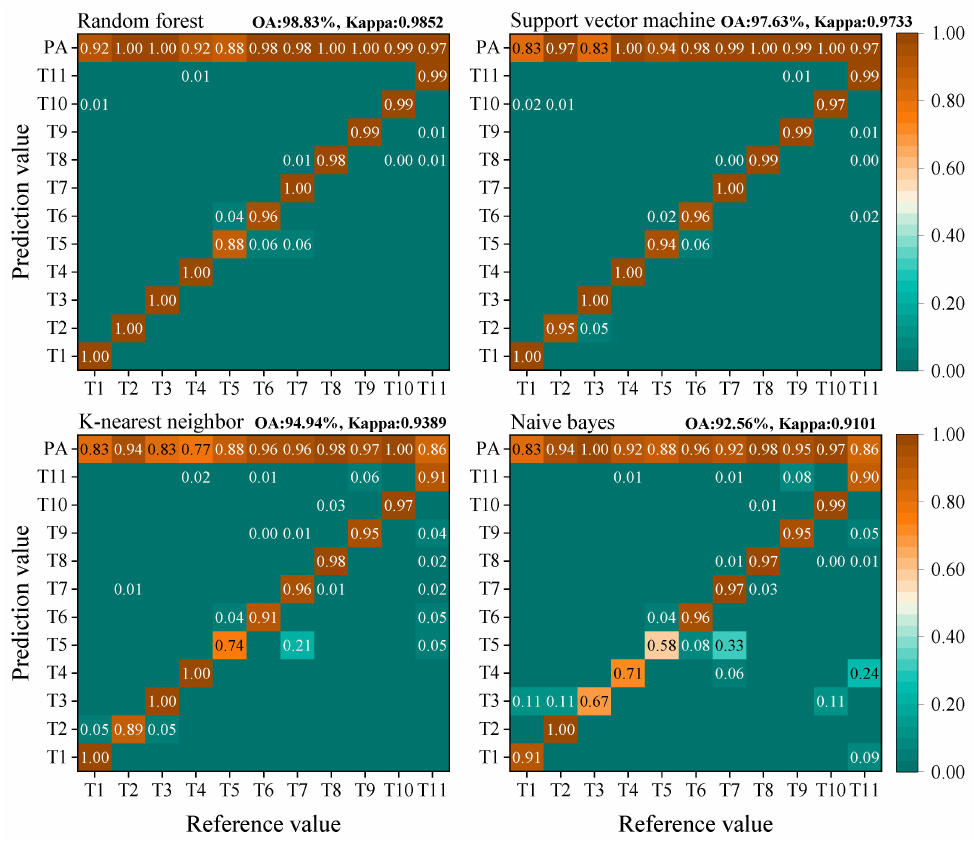
Figure 8. Confusion matrices for the optimized object-based